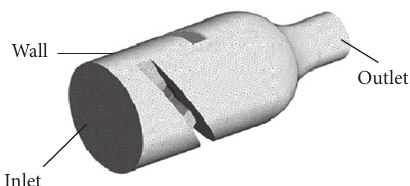
Figure 3: Calculation model of the swirl